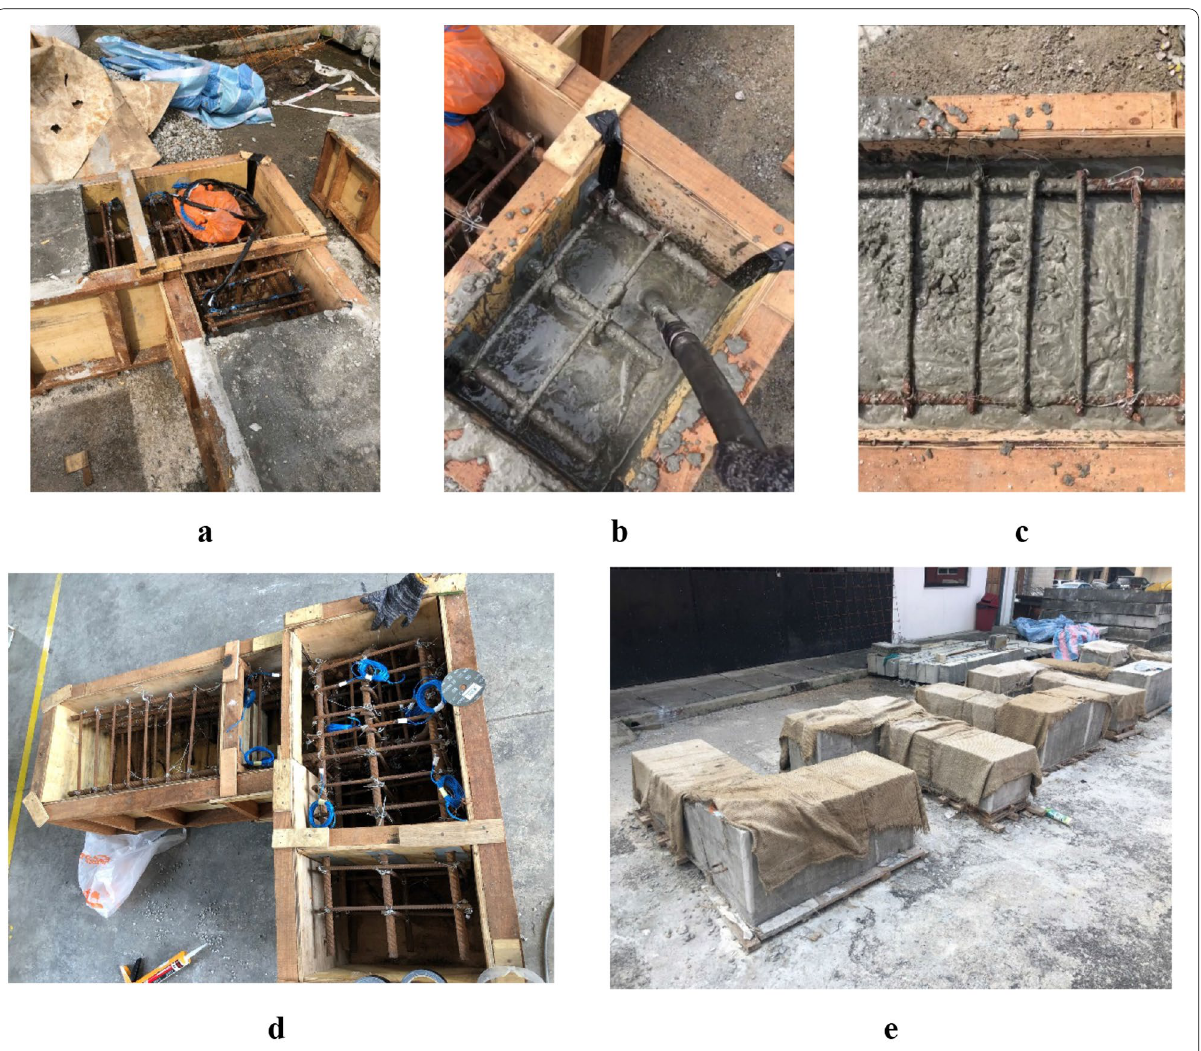
Fig. 2 The a casting of plain concrete on beam–column sections, b concrete compaction and fresh concrete inside the beam–column molding, c casting of HyFRC on the beam-column joint region, d strain gages installed on the steel reinforcements and e moist-curing of the HyFRC specimens using wet